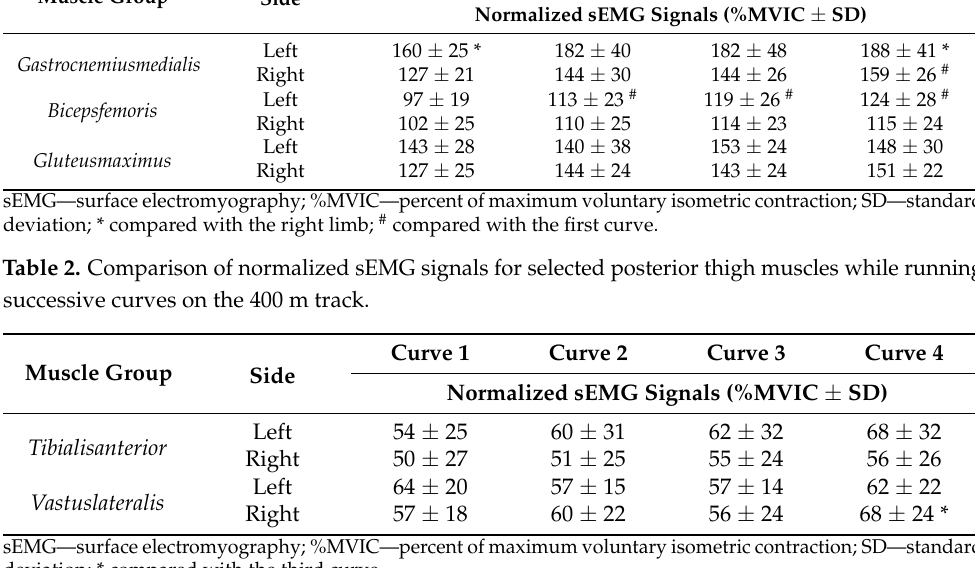
Table 1. Comparison of normalized sEMG signals of selected posterior thigh muscles while running successive curves on the 400 m track. Curve 1 Curve 2 Muscle Group Side